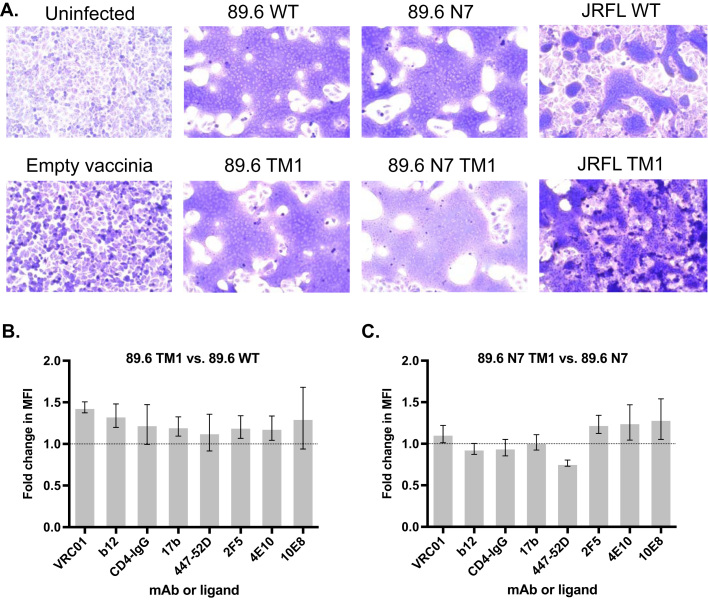
TM1 modified Env is functional and maintains broadly neutralizing antibody epitopes. (A) A cell-cell fusion assay was performed by infecting (MOI = 1) HIV-permissive TZM-bl cells with recombinant VACV vectors encoding HIV-1 Envs with WT or TM1 mutated CTs or a control VACV encoding no recombinant gene. Cells were fixed at 18 h and syncytia were visualized by Giemsa stain. (B, C) HEK 293T cells were transduced with recombinant VACV vectors encoding (B) the HIV-1 89.6 or (C) 89.6 N7 (N197Q) Envs with WT or TM1 mutated CTs, and cells were stained (N = 3) under non-permeabilizing conditions with the indicated mAbs or a CD4-IgG fusion protein. Fold changes in MFI (TM1:WT) for each mAb were normalized to the fold change in 2G12 stain to account for differences in surface expression. No significant fold differences (p > 0.05) relative to parental Env (dashed line) were noted using one-sample t-test on log-transformed data with Bonferroni correction.